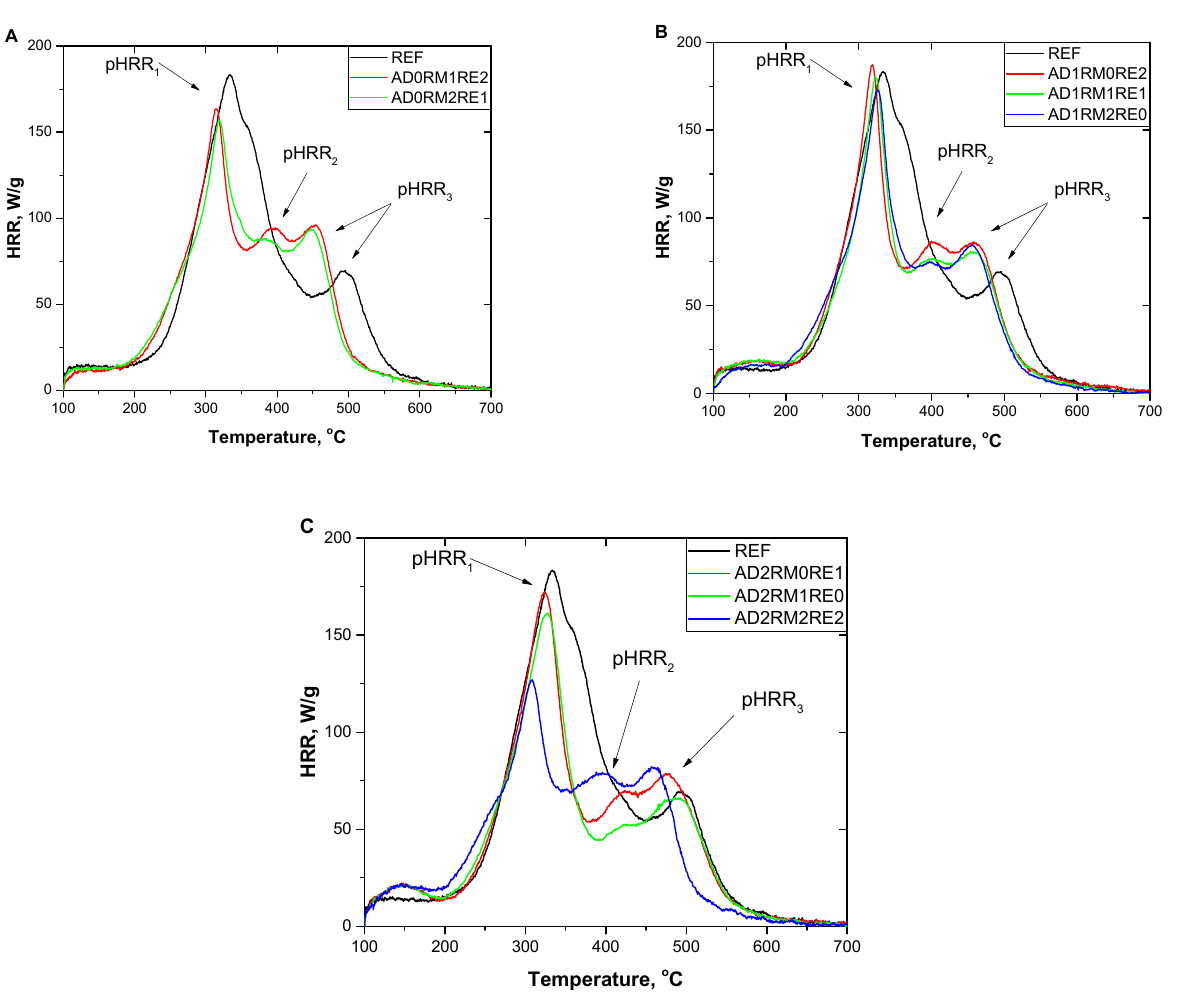
Figure 7. HRR curves of foams without AD ( A ), with 10% AD ( B ), and with 20% AD ( C ). The addition of flame retardants reduced the total heat released (Table 6). The lowest THR and HRC values with the AD content equal to 0, 10, and 20% were found in the foams containing the highest amount of RM. The combination of AD and RM allowed the most effective reduction of total heat release compared to other compositions. The PURFs containing 10% AD had a similar ability to release heat and pHRR 1 compared to the reference foam. The AD-free foam materials had an HRC value of about 175 J/g · K. In the case of foams with the addition of 20% AD, the highest HRC value was found for the AD2RM0RE1 material, and the lowest AD2RM2RE2, equal to 189 J/g · K and 136 J/g · K, respectively, so the increase the content of RM in these foams resulted in a reduction of the heat release capacity as well as pHRR 1 . The temperature at which pHRR 1 is reached has decreased after the addition of flame retardants. For AD-free foams, this temperature decreased by about 16 ◦ C. In the case of materials with 10% AD content, there was a decrease in Temp 1 for the AD1RM0RE2 foam by 14 ◦ C, and as the RE content decreased, this difference decreased to 9 ◦ C for the AD1RM2RE0 foam compared to the reference foam. Materials containing 10 wt.% of reactive flame retardants achieved pHRR1 at a temperature about 7 ◦ C lower than the unmodified foam. However, the greatest reduction in Temp 1 was observed for the AD2RM2RE2 material. Only visible in modified foams, pHRR 2 for constant AD contents of 0, 10, and 20 wt.% decreases with the increasing RM content. The addition of modifiers increased the pHRR 3 , except for the AD2RM1RE0 foam. Increasing the content of RM and decreasing the content of RE resulted in a decrease in pHRR3. The pHRR 2 peak reaches its maximum at